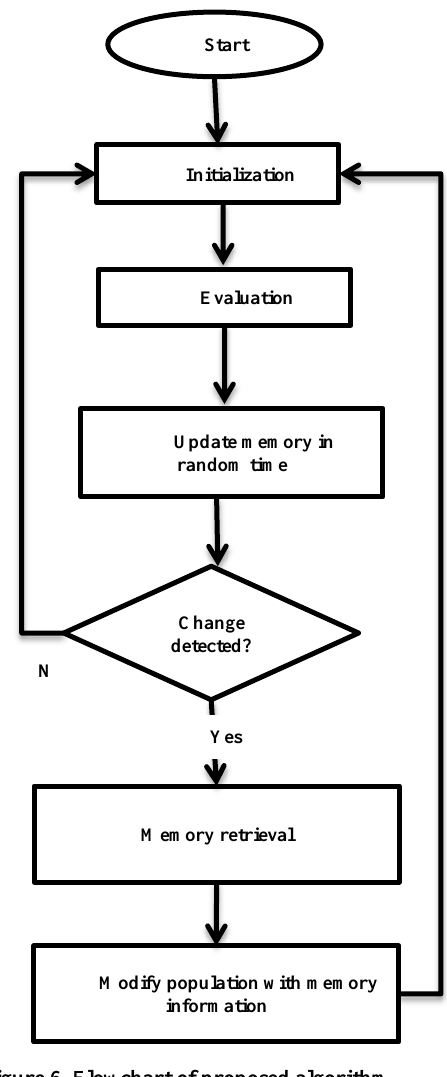
Figure 6. Flowchart of proposed